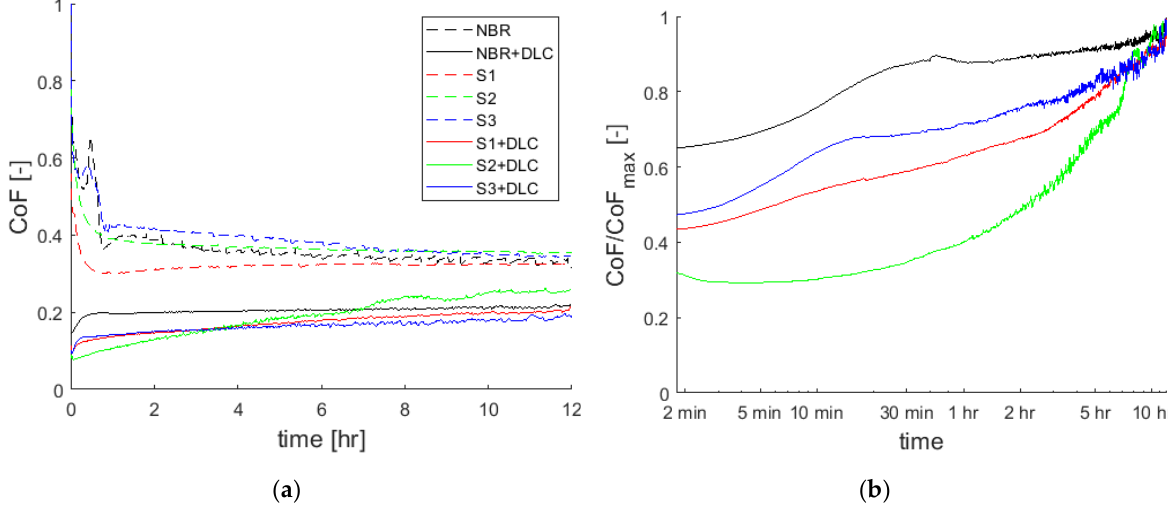
Figure 7. ( a ) Friction coefficient of different elastomer samples; ( b ) evolution of the normalized friction coefficient for DLC coated elastomers.